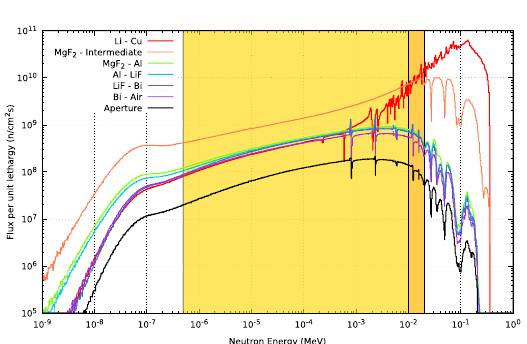
Figure 6. Neutron spectra at different positions of the BSA from the Lithium target to the aperture. The spectrum shaping effects from each material are exhibited. Also, an intermediate scoring plane in MgF 2 is shown. The epithermal range from 0.5 eV to 10 keV is marked in gold and the extension from 10 to 20 keV in pale